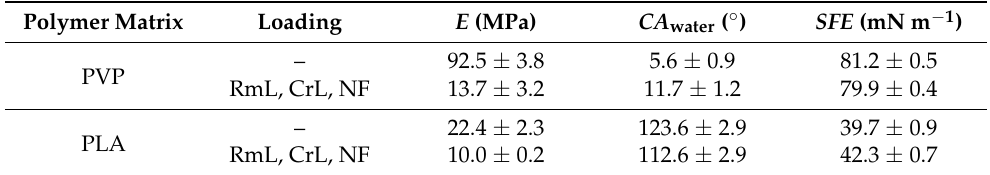
Table 2. Characterization of PVP and PLA nanofibrous matrices without loading and loaded with lipases (RmL, CrL) and nadifloxacin (NF): the effect of loading components on the Young’s modulus € , contact angle ( CA ) and Surface free energy ( SFE ) of